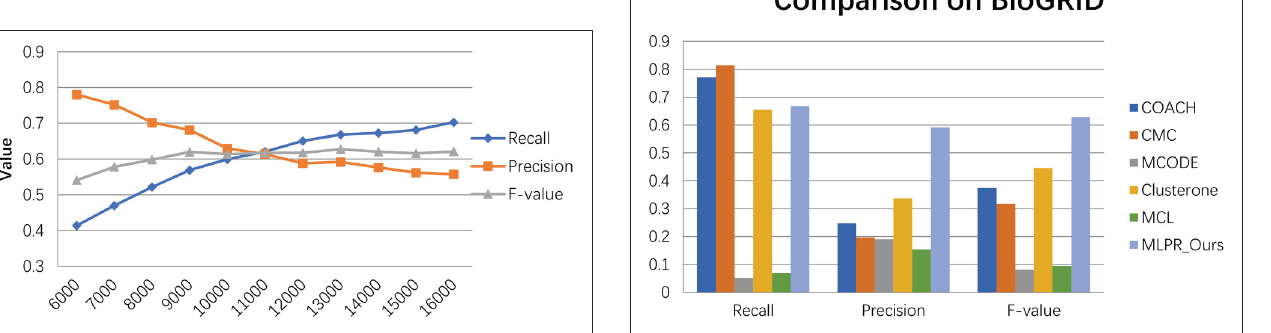
FIGURE 6 | The performances comparison between our method and other five methods on BioGRID dataset.